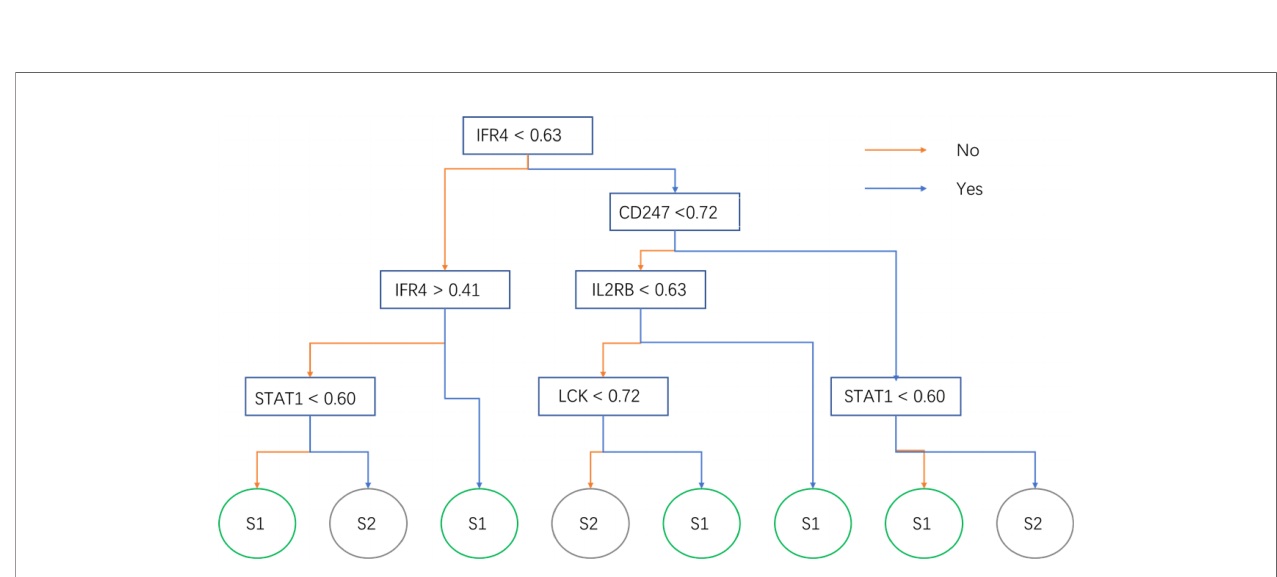
FIGURE 6 | The optimal decision tree in the random forest model. The sample will be predicted into subtypes 1 or 2 by its gene